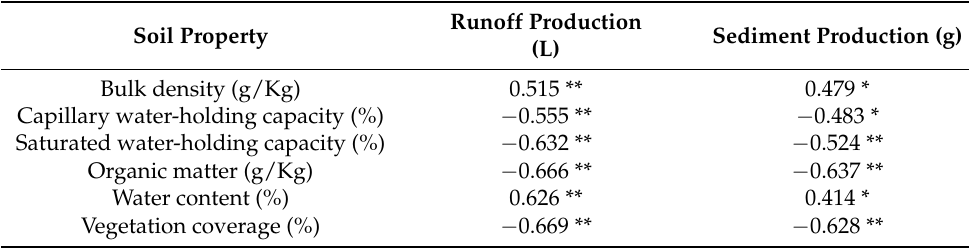
Table 4. Correlation analysis of soil characteristics, vegetation coverage, and runoff and sediment yield under different ecological protection measures. Runoff Production Soil Property Sediment Production (g) (L) Bulk density (g/Kg) 0.515 ** 0.479 * Capillary water-holding capacity (%) − 0.555 ** − 0.483